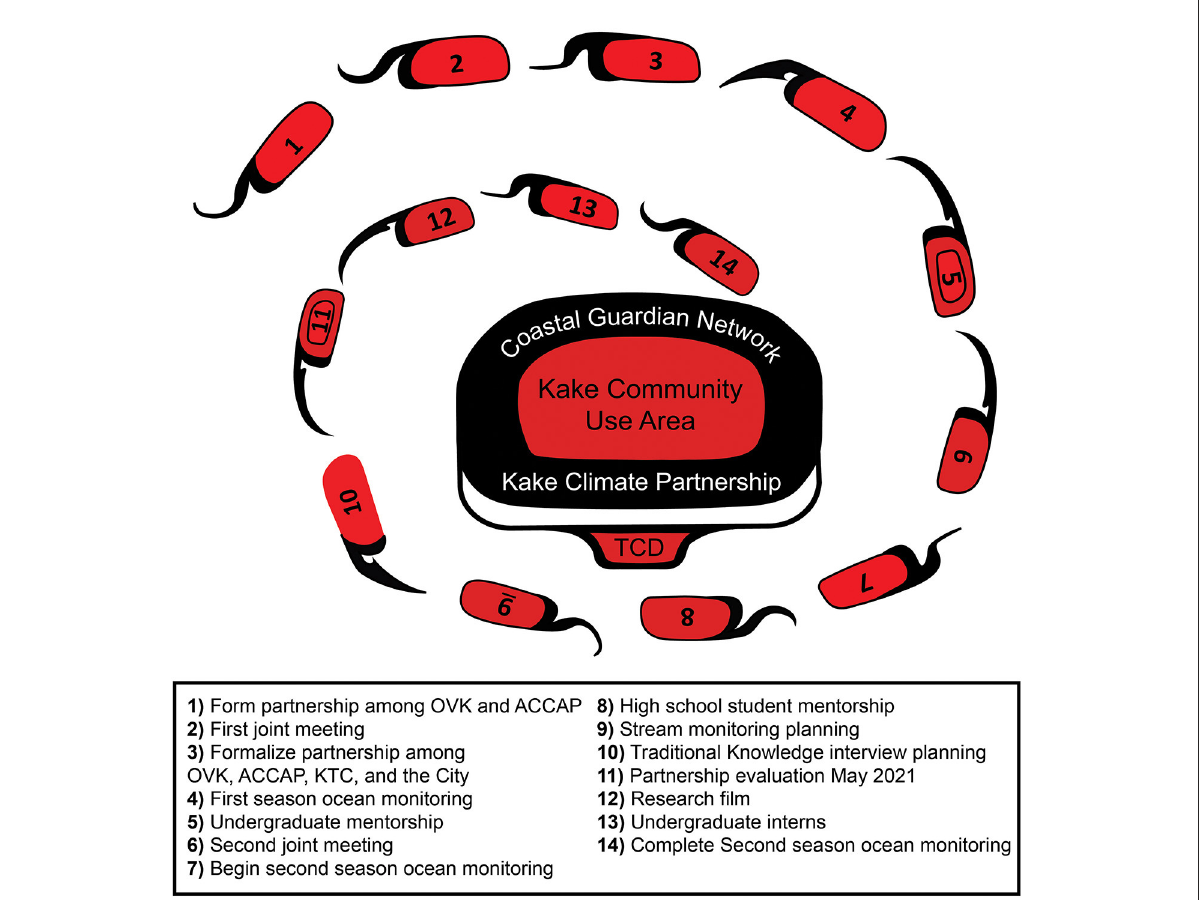
FIGURE7 Traditional Tlingit formline drawing techniques to display actions and processes that lead to a co-production learning network. The large ovoid in the center of the figure represents the center of the eye. The Kake Climate Partnership forms the base of this central ovoid, and acts as a seed for the future Coastal Guardian Network (see Table 2). The Coastal Guardian Network is situated across the top of the central ovoid, as a goal for the future. The ‘TCD’ stands for the Tribal Conservation District (see Table 2), which has a root connection to the ovoid in the eye and supports everything above it. The Kake Community Use Area is in the innermost ovoid, as the central point of all efforts. Each small ovoid with a tail on it is unique and symbolizes a main event from the first 24 months of the Kake Climate Partnership—actions partners have taken as a team to build the Partnership and support the long-term vision in Kake. Each small ovoid with a tail is numbered. The numbers correspond to a key underneath the spiral that displays descriptions of each major accomplishment of the Kake Climate Partnership during the 2 years of this study. Artist credit: B. Ki’yee Jackson; digitized by M.